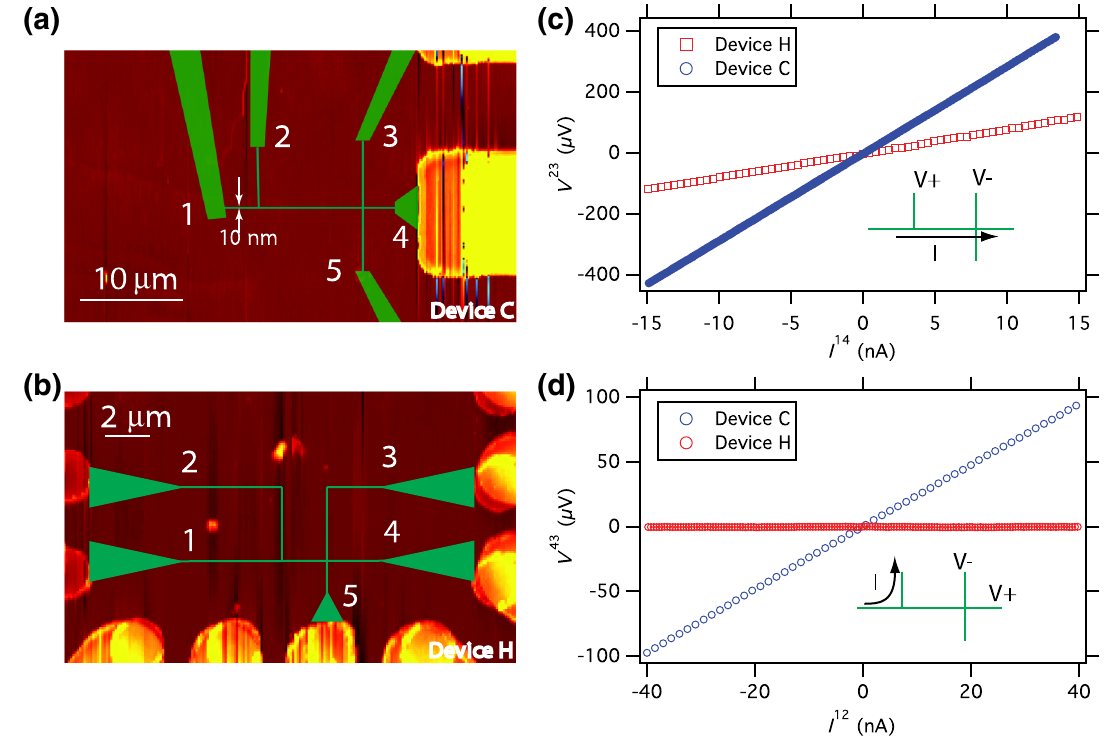
FIG. 1. Device schematic and electrical characterization of LAO/STO nanostructures. (a) Five-terminal structure (device C, overlaid on an AFM canvas image) composed of W ¼ 10 - nm -wide conducting nanowires (green), including an L ¼ 10 - (cid:1) m -long main channel surrounded by insulating (red) background. (b) Five-terminal nanowire (device H) formed in a similar fashion ( W ¼ 10 nm , L ¼ 2 (cid:1) m ). (c) Longitudinal I - V curves for devices C and H at T ¼ 400 mK . The inset shows the direction of current flow and voltages measured. (d) Nonlocal I - V curves for devices C and H at T ¼ 400 mK . The inset shows the direction of current flow and voltages